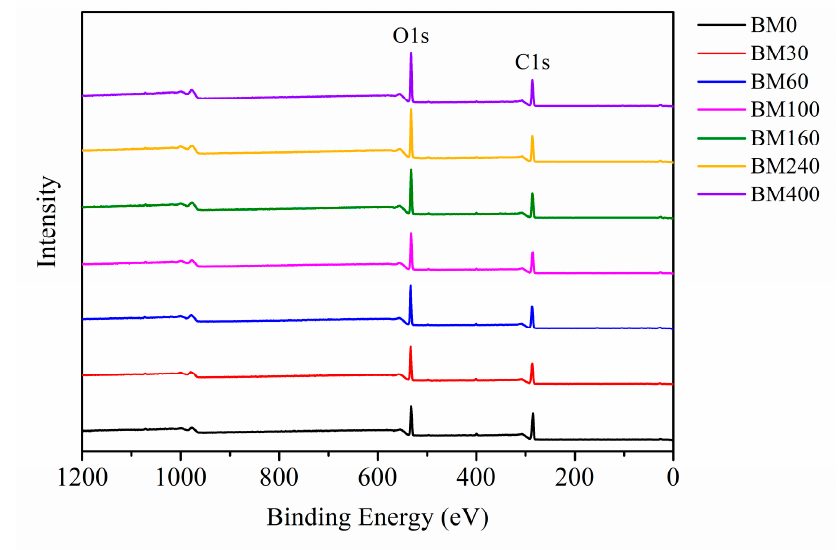
Figure 7. XPS spectra of PIDF at different scales.